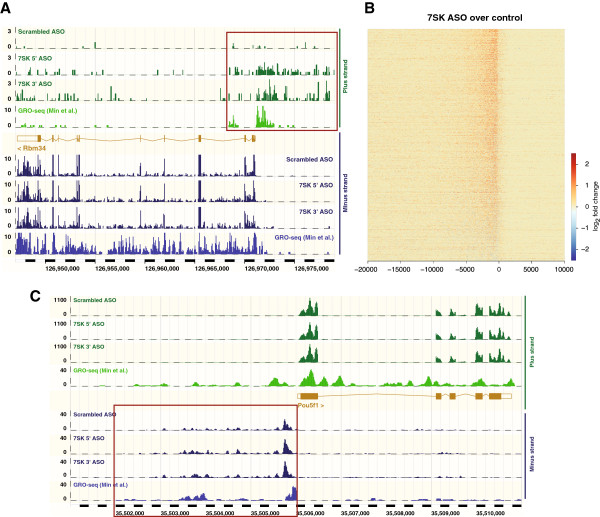
7SK represses upstream divergent transcription. (A) Ensembl genome browser image of the Rbm34 locus, showing normalized RNA sequencing (RNA-seq) read coverage (mean of two biological replicates) for ESCs nucleofected with scrambled control antisense oligonucleotides (ASOs) or 7SK ASOs. Published global run-on sequencing (GRO-seq) data for ESCs [1] indicated occupancy of transcriptionally engaged Pol II. Purple box highlights upstream divergent RNA (udRNAs). The plus (green) and minus (blue) strand reads are displayed in separate tracks. (B) Change in udRNA expression after 7SK knockdown for all 2676 genes (rows) with a detected udRNA. Colors indicate fold change on the antisense strand in 50 bp windows around the transcription start site (TSS). (C) RNA-seq and GRO-seq read coverage at the Pou5f1 (Oct4) locus. The udRNA region is highlighted in purple box. Note that different scales are displayed for plus/minus strand and GRO-seq tracks in panels (A) and (C).